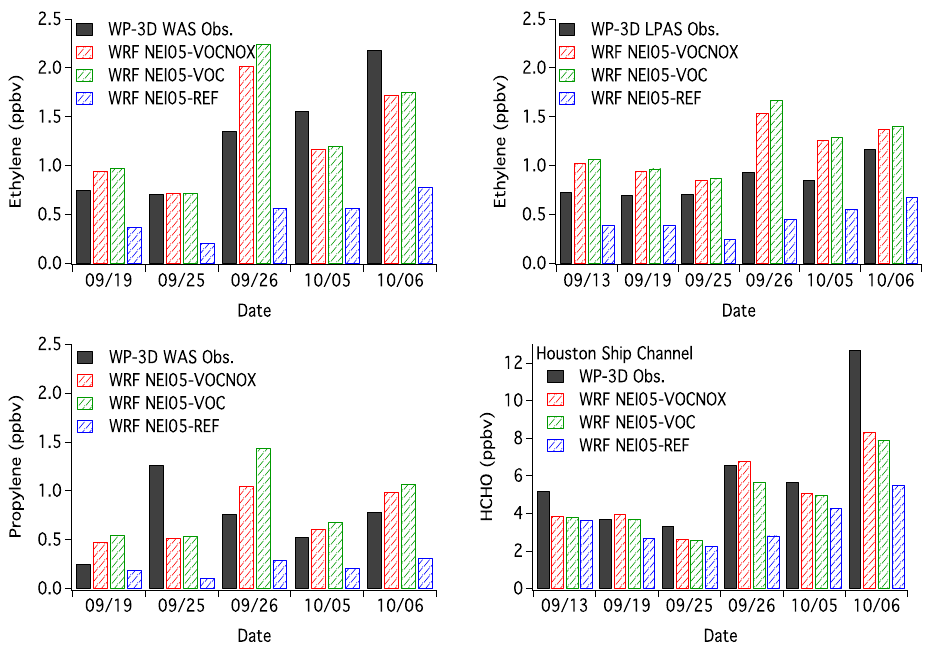
Figure 13. Plots comparing observed ethylene, propylene, and formaldehyde (< 1 km altitude above ground level) with the model results using the NEI05-REF, NEI05-VOC, and NEI05-VOCNOX inventories over the Houston area. For formaldehyde, the data over the Houston Ship Channel area are used. Table 10. Averages of observed and modeled ethylene and propy- lene for the model simulations using NEI05-REF and NEI05-VOC. WAS denotes the whole air sampler and LPAS stands for the photo- acoustic measurement of ethylene.